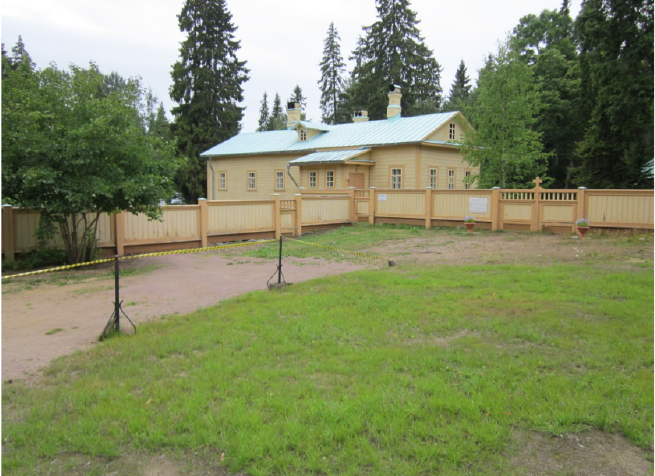
Figure 5 – Valaam monastery. Gethsemane skete (Yellow). XXI